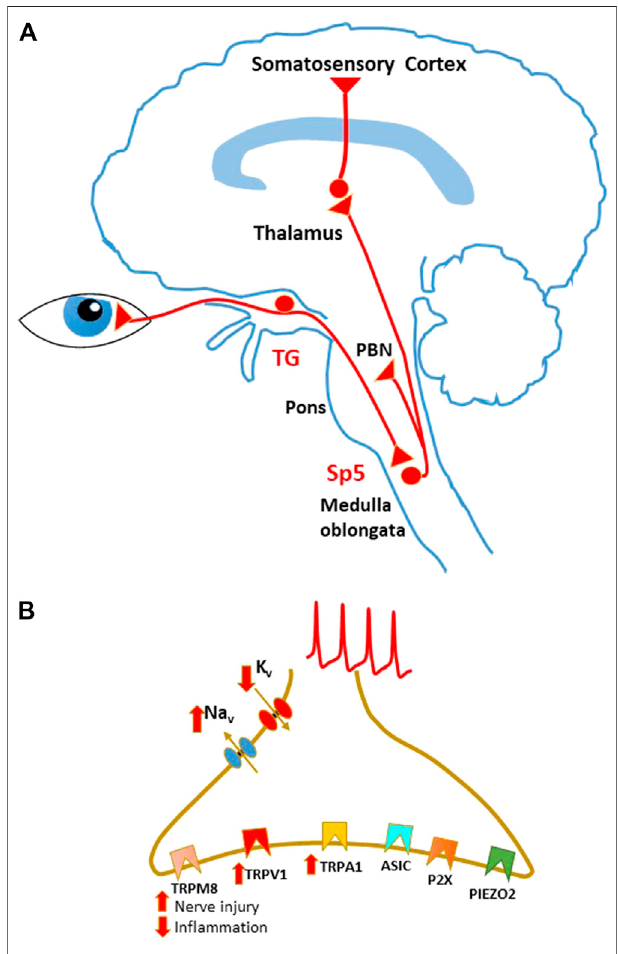
FIGURE 1 | Schematic representation of sensory pathways involved in corneal pain transmission. (A) Sensory pathways conveying corneal nociceptive input to the central nervous system. Corneal sensory input is transmitted by corneal nociceptors, whose cell bodies are located in the trigeminal ganglion (TG). Central terminals of nociceptors project to the spinal trigeminal nucleus (Sp5) in the brain stem. Projection neurons in these regions sendascendingpathwaystoseveralareas,includingtheparabrachialnucleus (PBN) and the thalamus, that in turn project to higher centers. (B) Principal ion channels involved in corneal sensory transduction on the nociceptor peripheral terminals. During peripheral sensitization, TRPV1 and TRPA1 are usually upregulated, while TRPM8 function is enhanced in neuropathic pain and decreased during in fl ammation.